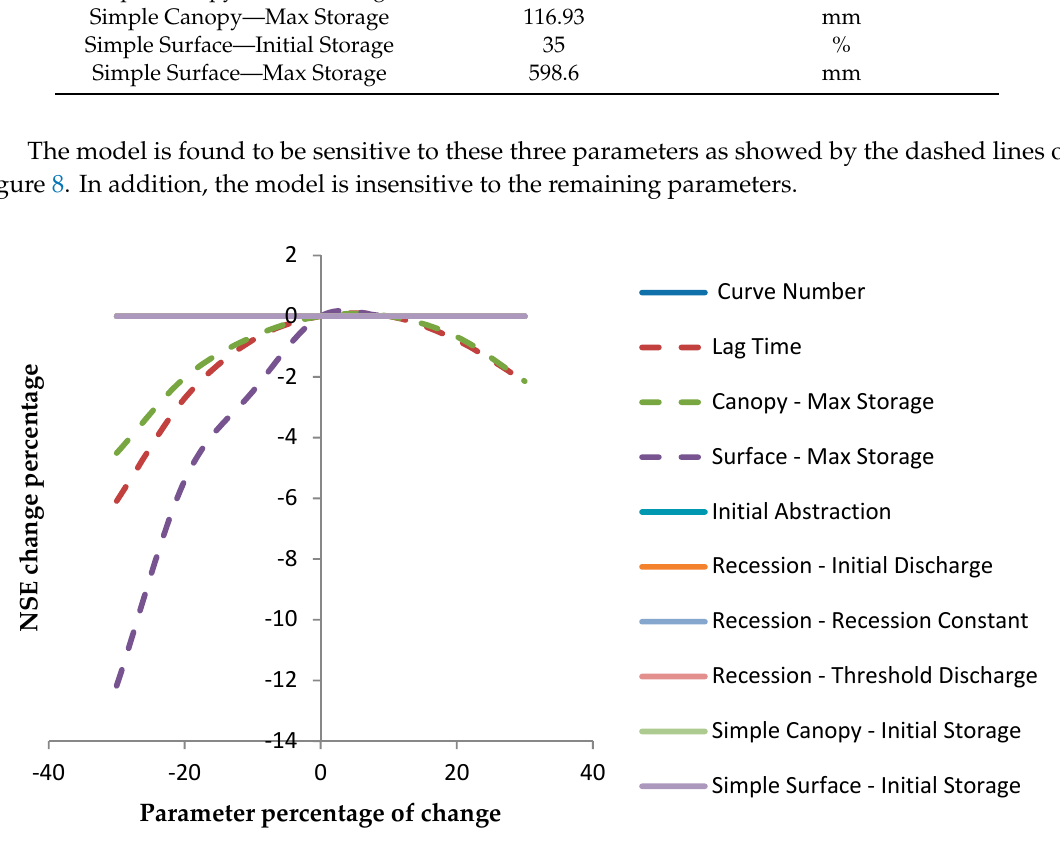
Table 9. Results of Monte Carlo Analysis with 500 Trials. Statistics